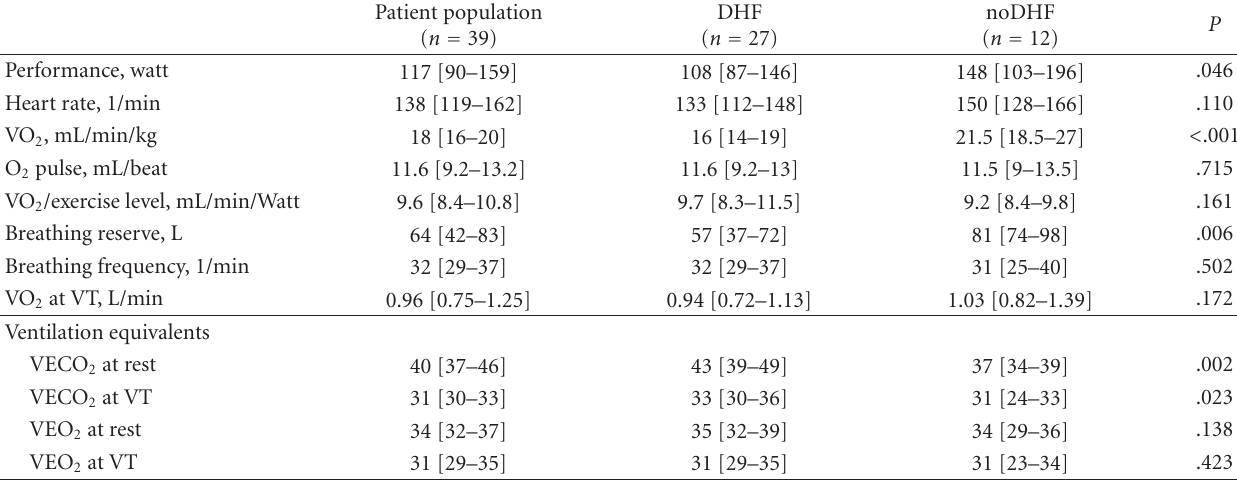
Figure 2: Linear regression between peak performance and LV sti ff ness in all patients (above, n = 39) and in HFNEF patients with increased LV sti ff ness (below, n = 27). Sti ff ness beta indicates exponential curve fit to end-diastolic PV relationship, r correlation coe ffi cient, and P significance level. Table 4: Indices of cardiopulmonary exercise testing (variable expressed as median [25–75%